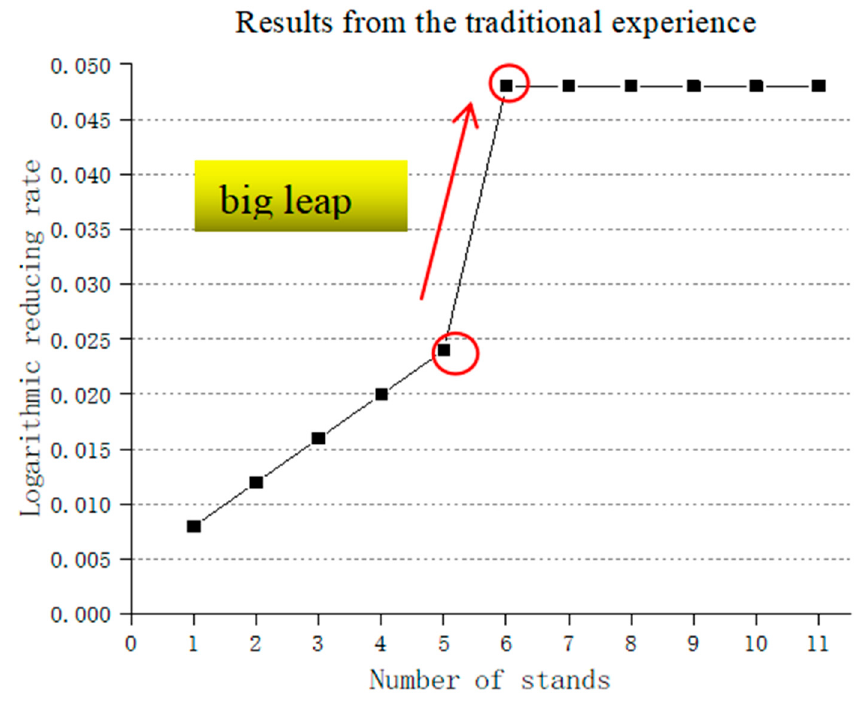
Figure 3. Reduction rate distribution method from conventional experience.